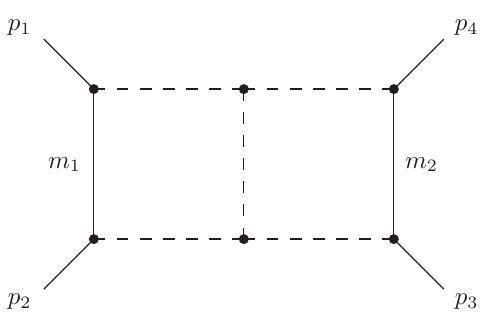
Figure 1: The H-graph. Solid lines denote massive objects, dashed lines denote mass- less particles.